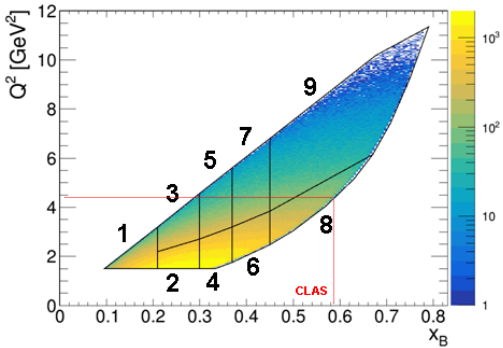
Figure 3: Q 2 vs x distribution accessible with CLAS12. The black lines and the B numbers indicate the binning scheme used for the multidimensional study. The red line illustrates the region which was accessible with